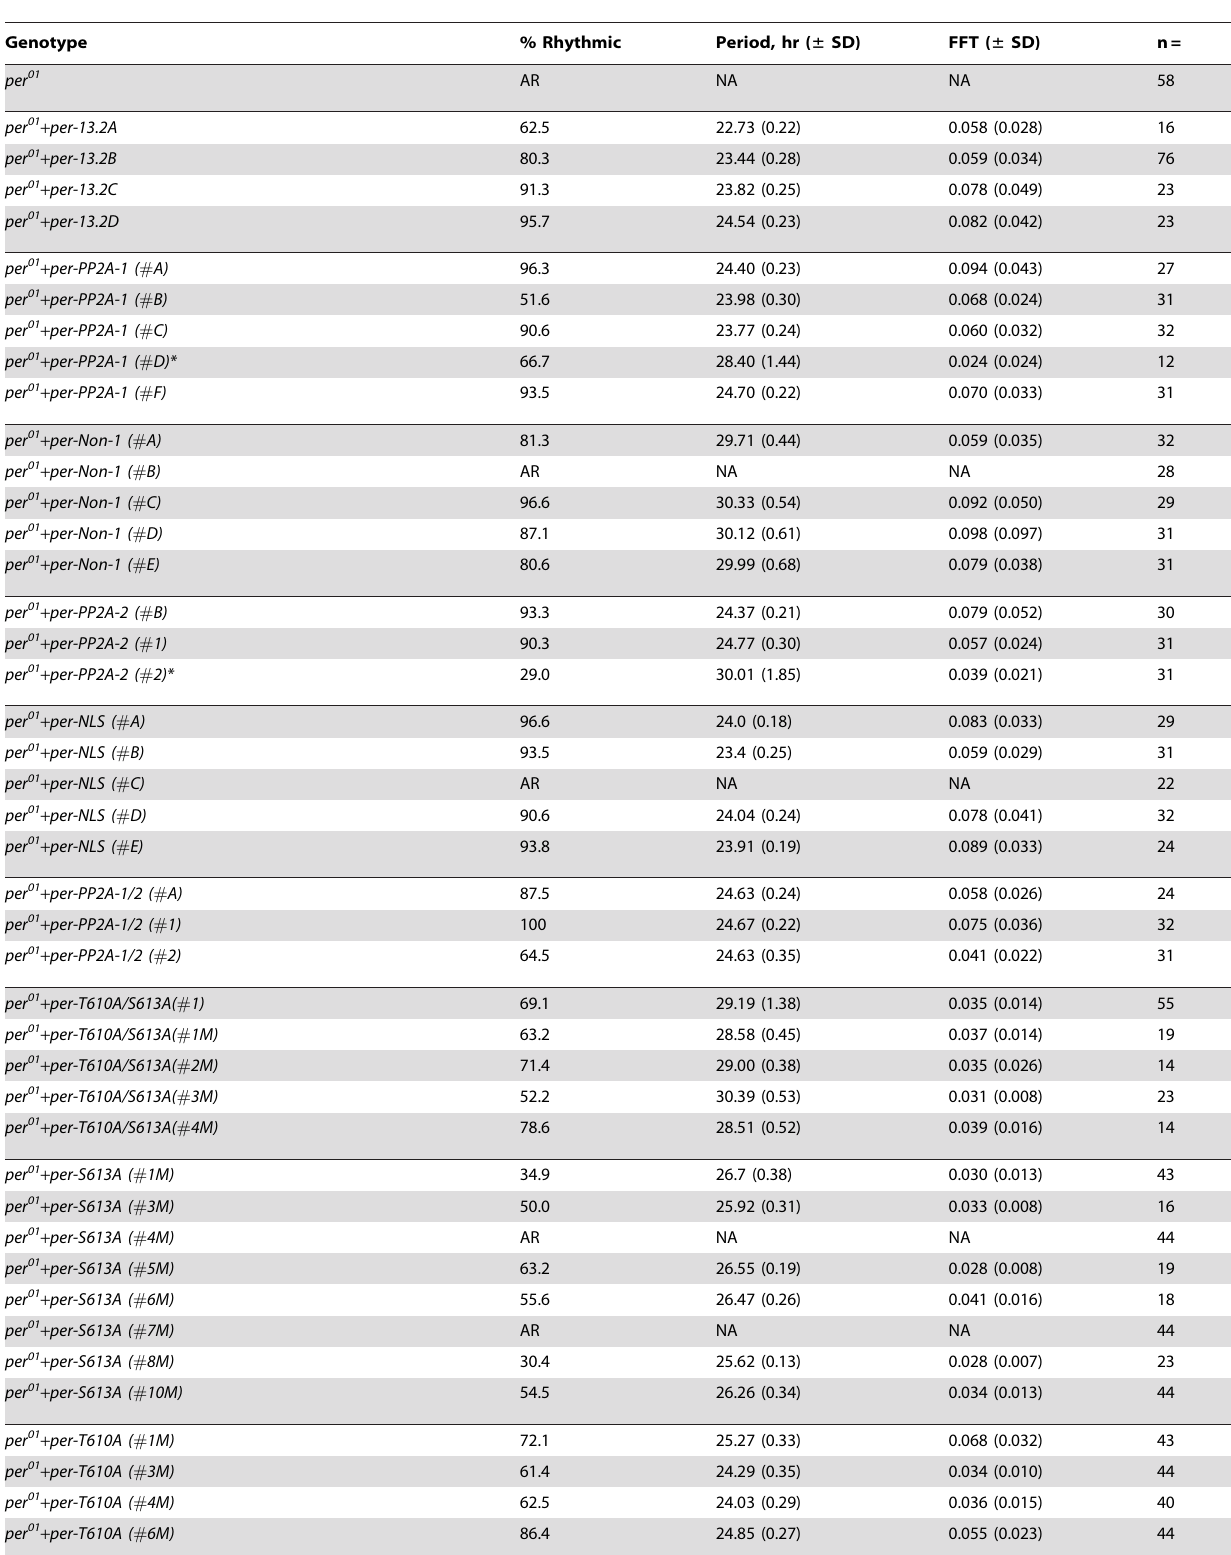
Table 1. Locomotor activity rhythms of per 01 mutants and transgenic lines used in this study (see Figures 3, 7 and 8).